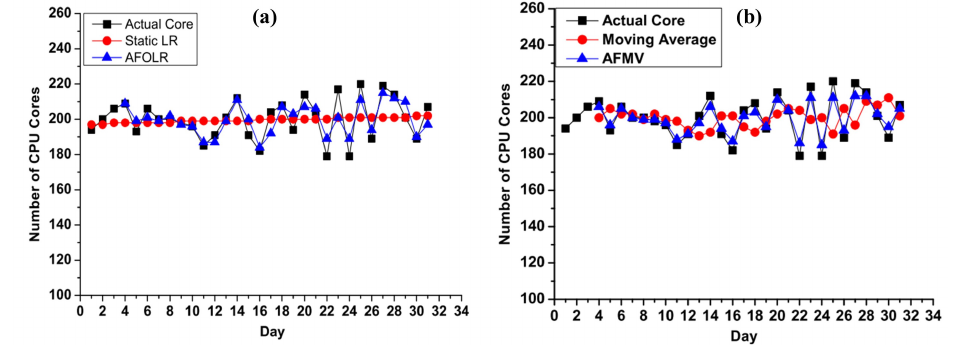
Figure 6. Sensitivity Analysis: ( a ) AFOLR vs. Traditional Linear Regression Technique (Static LR) and ( b ) AFMV vs. Traditional Moving